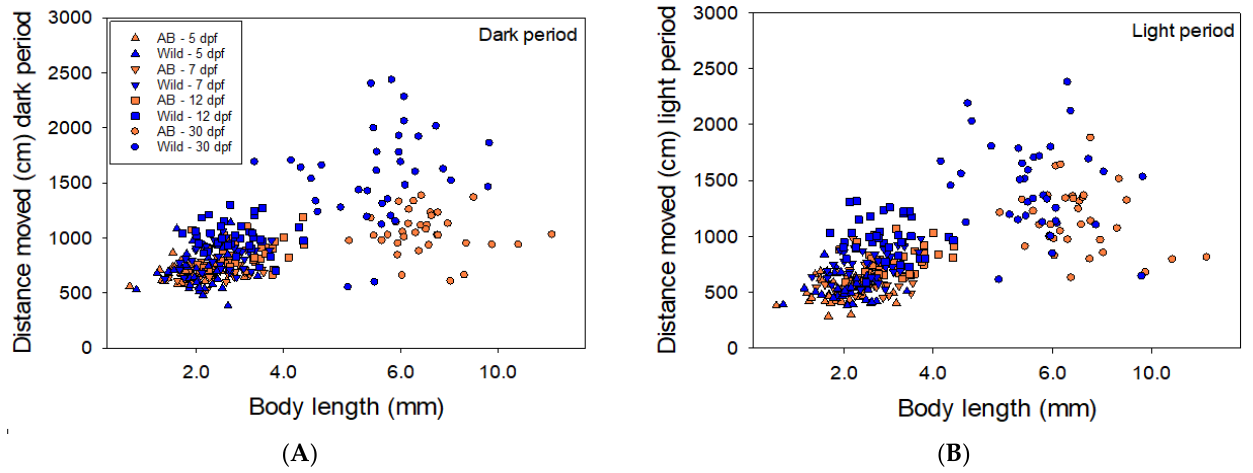
Figure 4. ( A , B ) Relation between body length and total distance move during the dark/light period in zebrafish juveniles. Filled symbols are AB strain and open symbols wild strain. Note that the x-axis is logarithmic. For statistics see Tables 1 and 2.